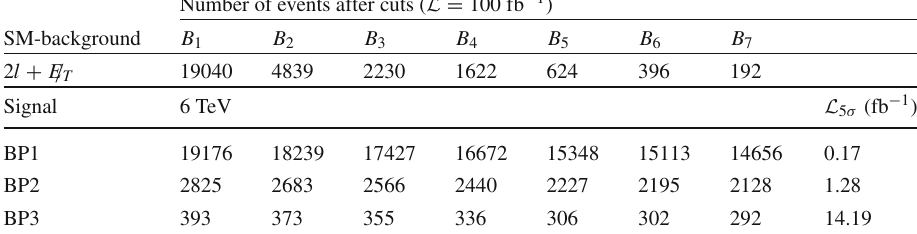
Table 4 The cut-flow for signal and backgrounds along with the required integrated luminosity to achieve 5 σ significance for the μ + μ − → 2 l + E T / channel for BP1, BP2 and BP3 at 6 TeV Muon